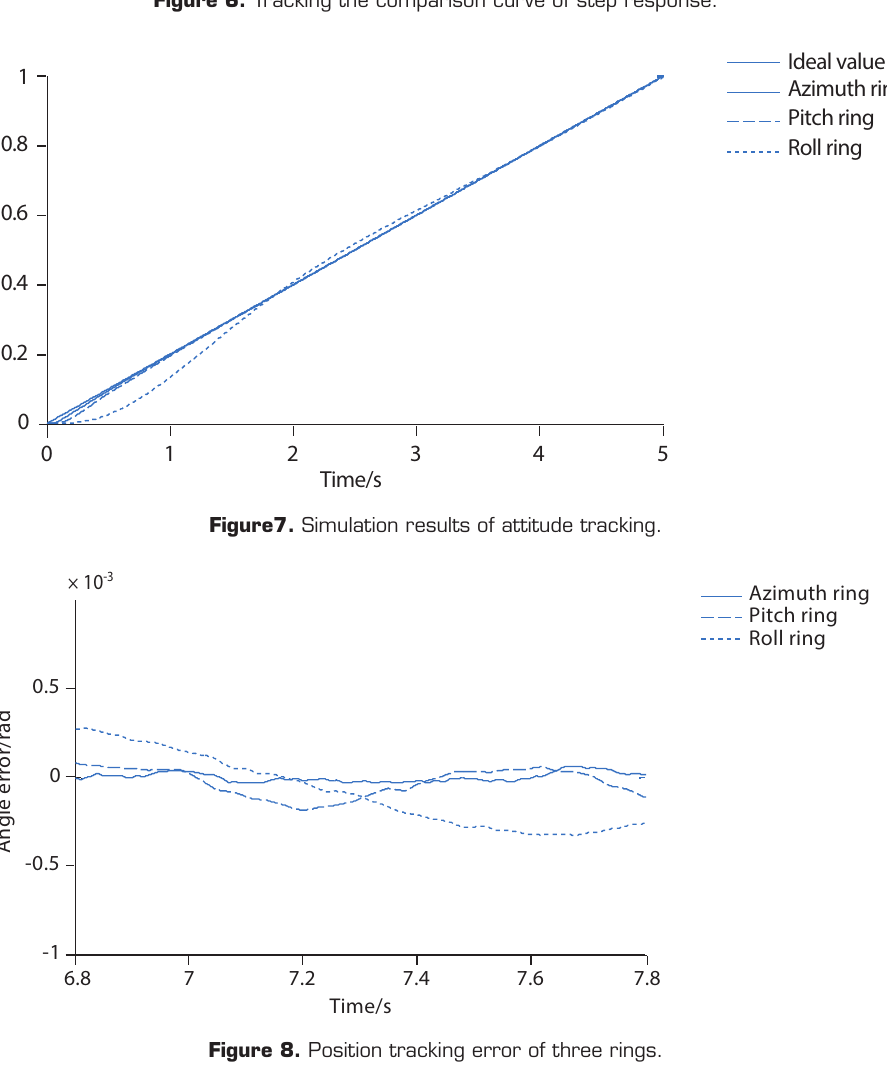
Figure 6. Tracking the comparison curve of step response.